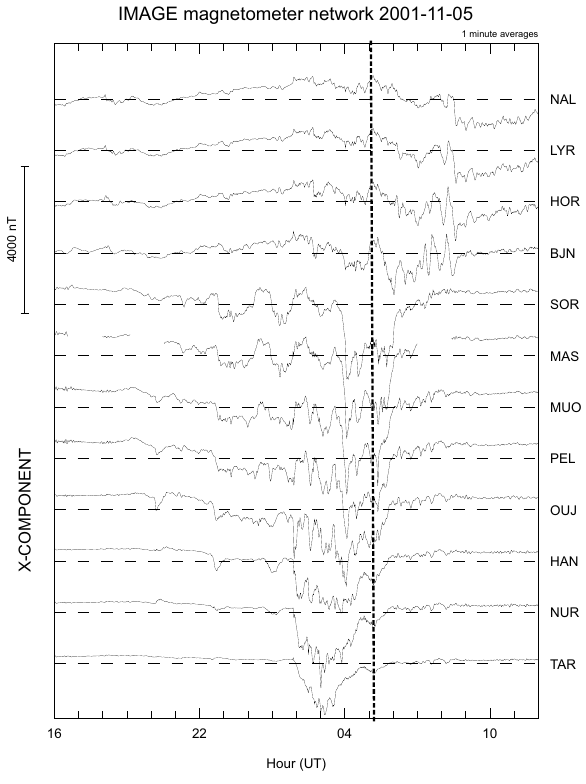
Fig. 4. Magnetograms of the IMAGE stations (for locations refer to Figure 1) of the storm event starting on 5 November 2001; B x component.